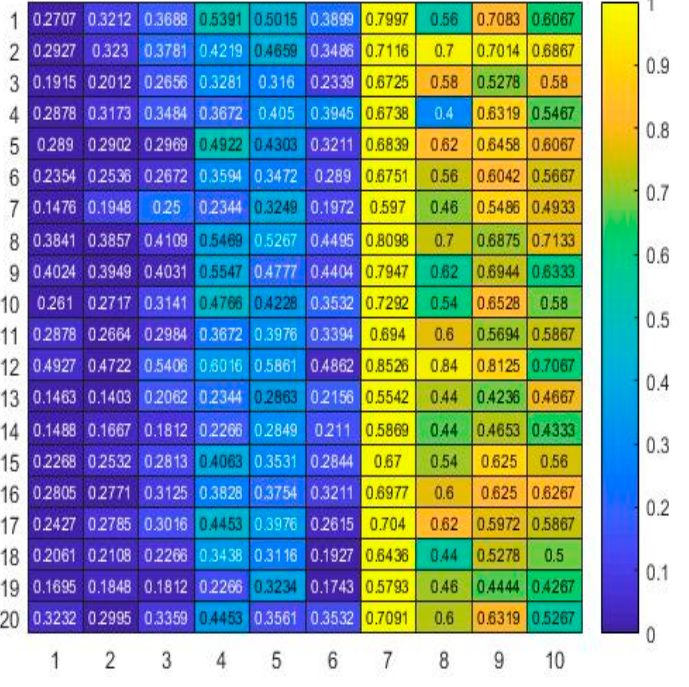
Figure 1. A heat map of the mean values attained with the experiments.